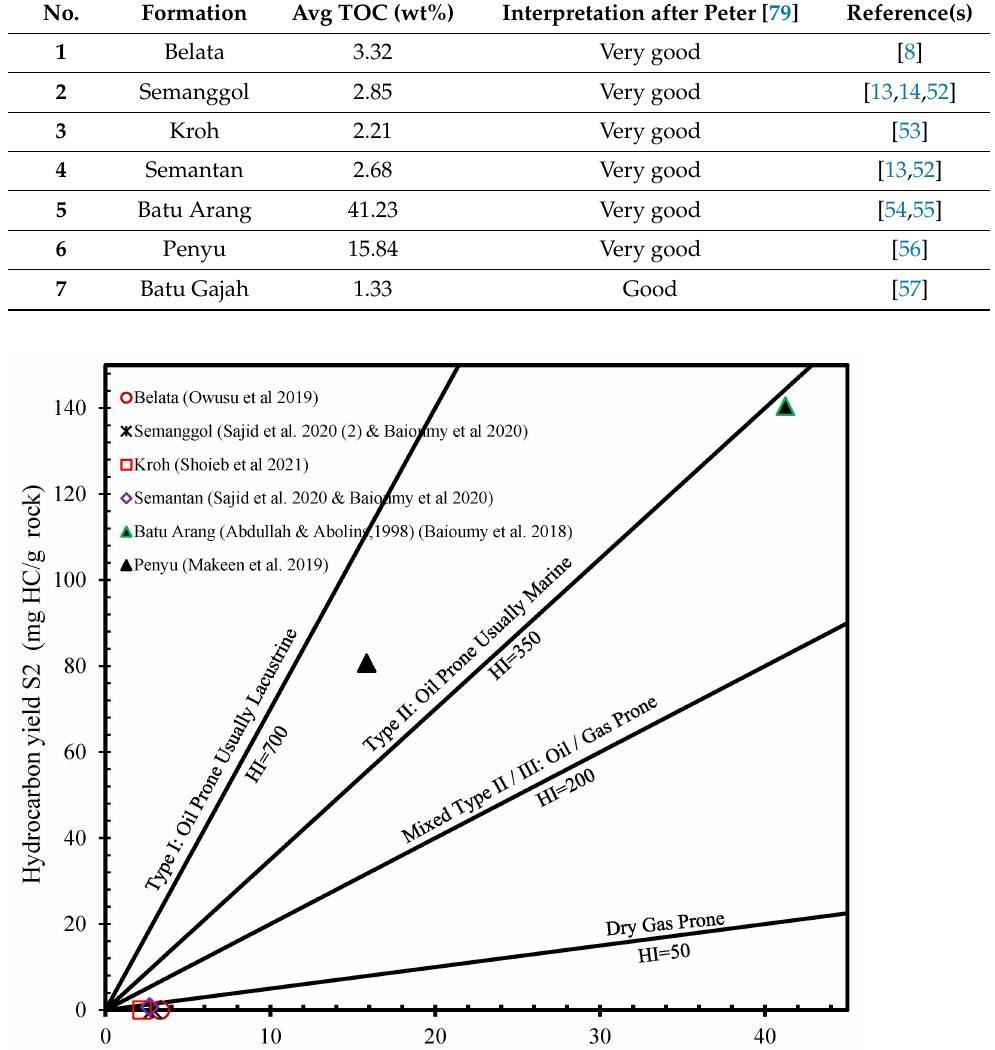
Table 2. Interpretation of average TOC values of formations in Peninsular Malaysia according to Peter [79].